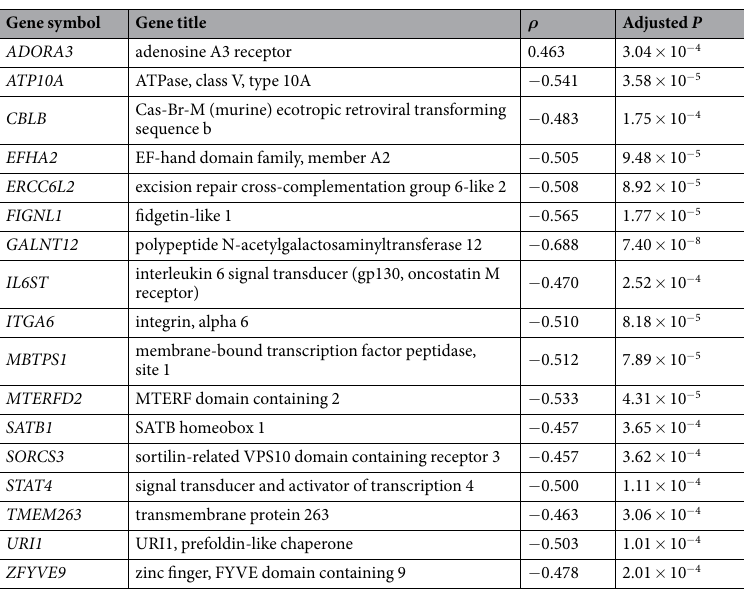
Table 3. 17-Gene Signature in Sarcoidosis. Note – ρ is the Spearman’s rank correlation coefficient. P -values were calculated by Spearman’s rank correlation test between protein-coding gene expression level and sarcoidosis severity and adjusted by Benjamini & Hochberg